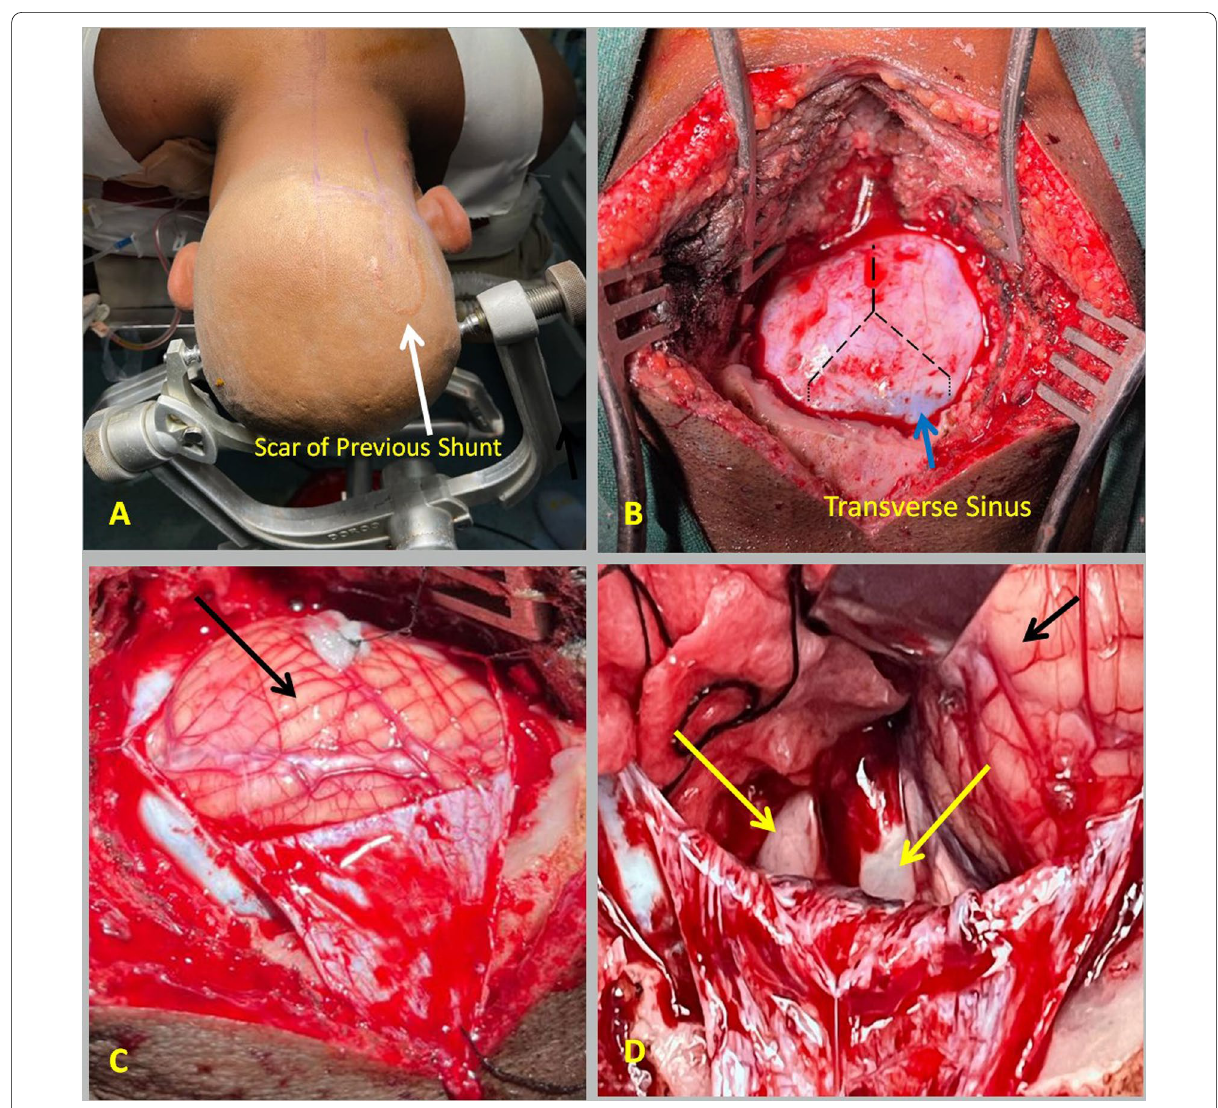
Fig. 4 Intraoperative pictures. a Position of the patient for lateral sub-occipital craniotomy, b upper extent of craniotomy, Blue arrow shows exposure of transverse sinus, Black broken lines show the plan of dural incision in "Y" shape, c after dural flaps reflection, the cerebellum is seen full and bulging. No tumor was visible on the surface. The black arrow shows the color and width of normal cerebellar folia, d after retraction of tentorial surface, Pale white and widen dysplastic folia were visible (Yellow Arrows), normal folia (black arrow)